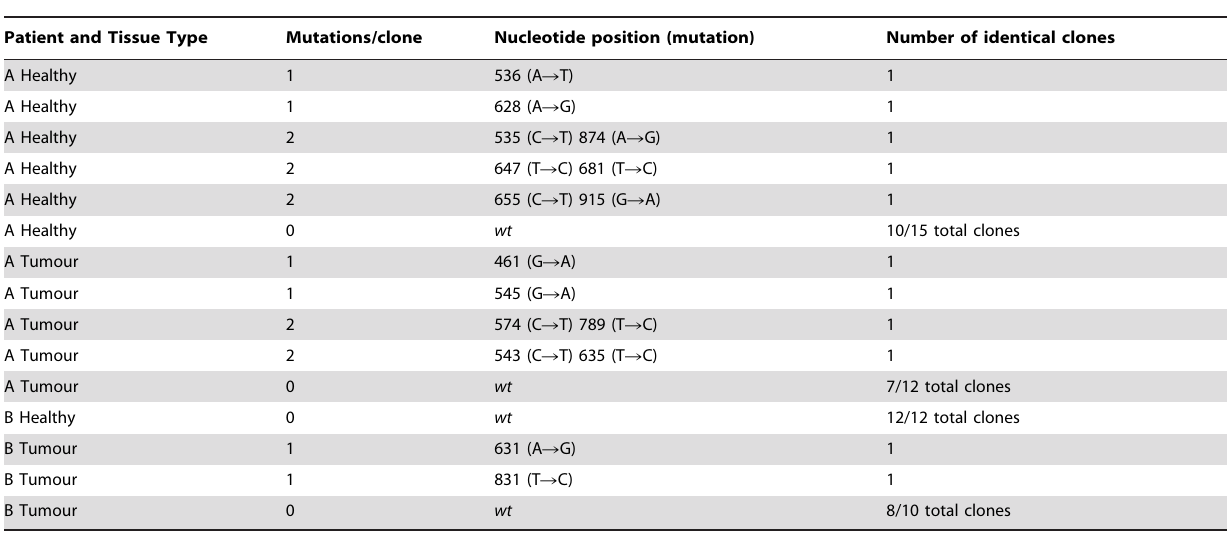
Table 3. Mutations in TP53 transcripts in tumour and nearby healthy